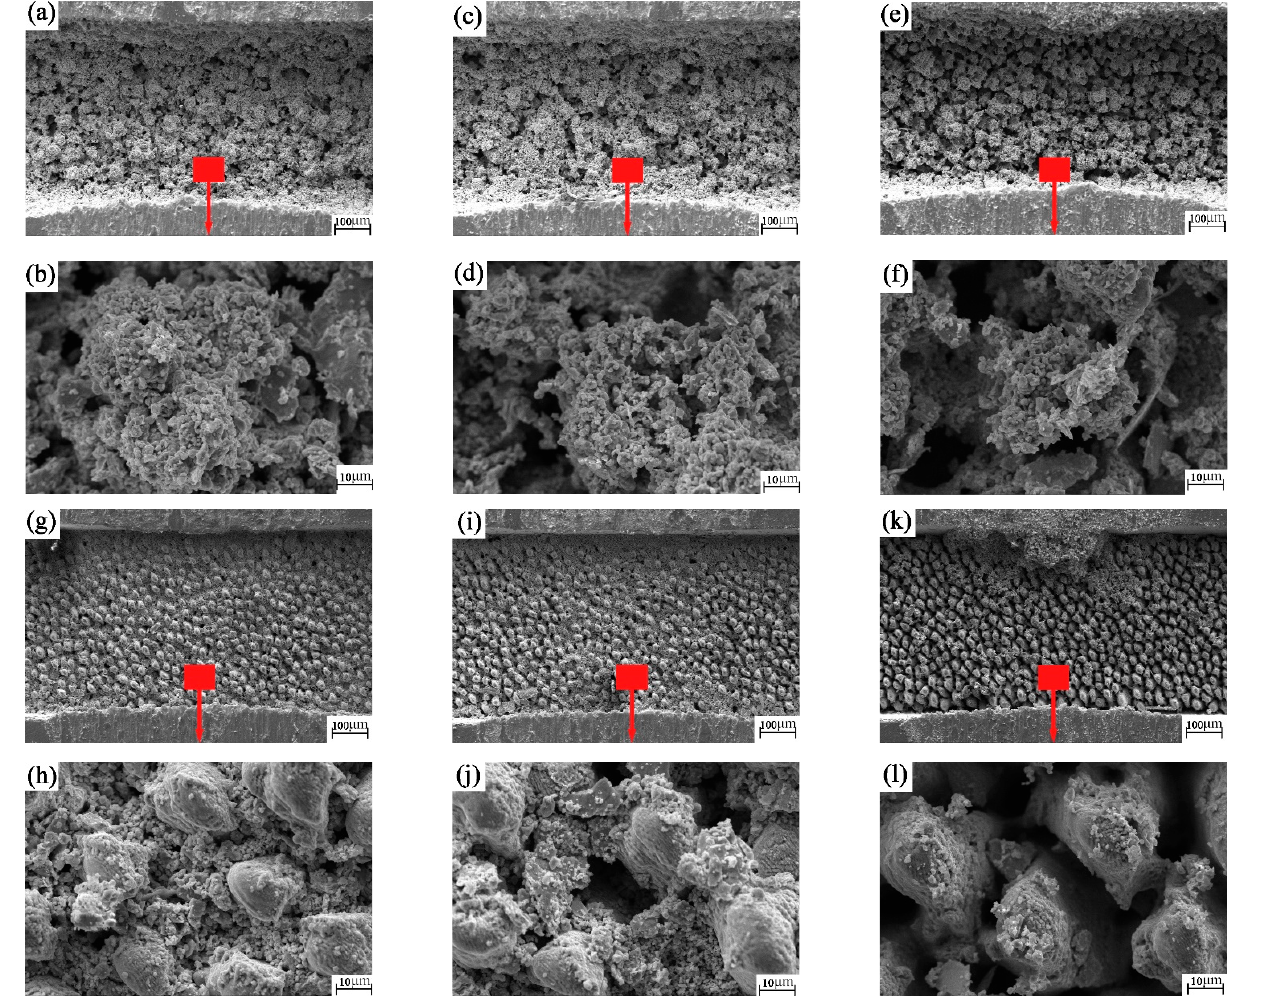
Figure 10. SEM images of the groove textured worn plates: ( a , b ) nanosecond texture rotation radius 15 mm; ( c , d ) nanosecond texture rotation radius 18 mm; ( e , f ) nanosecond texture rotation radius 22.5 mm; ( g , h ) picosecond texture rotation radius 15 mm; ( i , j ) picosecond texture rotation radius 18 mm; ( k , l ) picosecond texture rotation radius 22.5 mm.